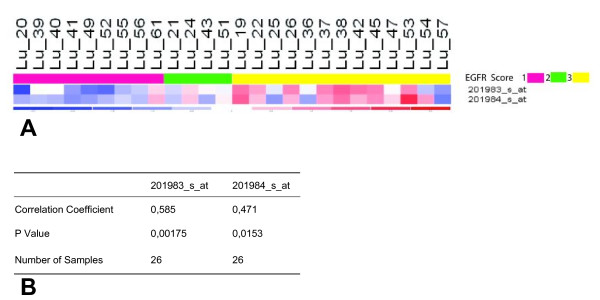
EGFR expression congruency. A: Comparison of the intensity of positive staining of EGFR obtained by immunohistochemistry and gene expression measured by Affymetrix gene chips: Gene expression values are congruent with EGFR detection on the protein level. The upper bar shows the EGFR expression on protein level (pink = no protein expression, green = incomplete membranous stain and yellow = complete membranous stain). The expression values of elements representing EGFR gene expression (middle) are indicated by color code shown in the lowest bar (blue = low gene expression and red = high gene expression). In B the results of the Spearmans Rank Order Correlation of the gene expression values obtained by microarray analyses and EGFR protein levels measured by IHC are shown.